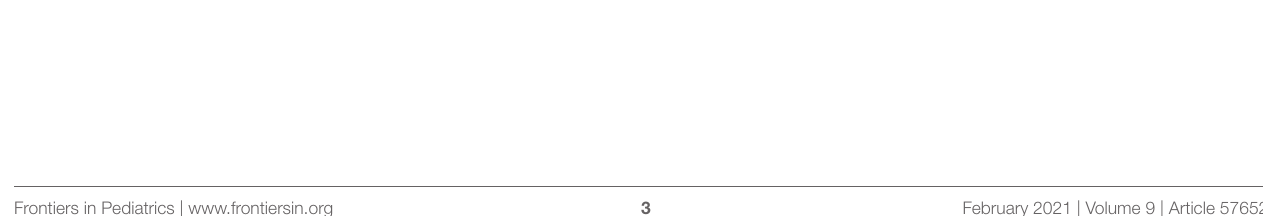
Frontiers in Pediatrics |